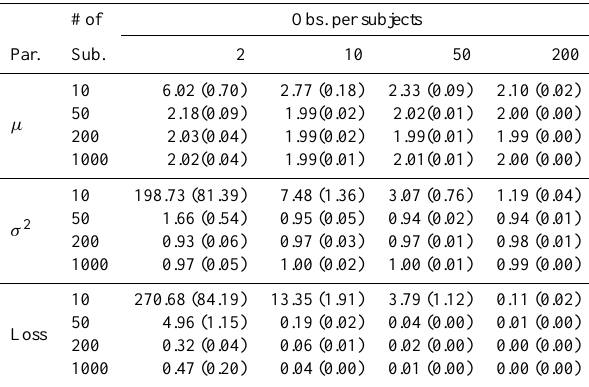
Table 4. glmmPQL simulation results: µ = 2, σ 2 = 1. # of Obs. per subjects